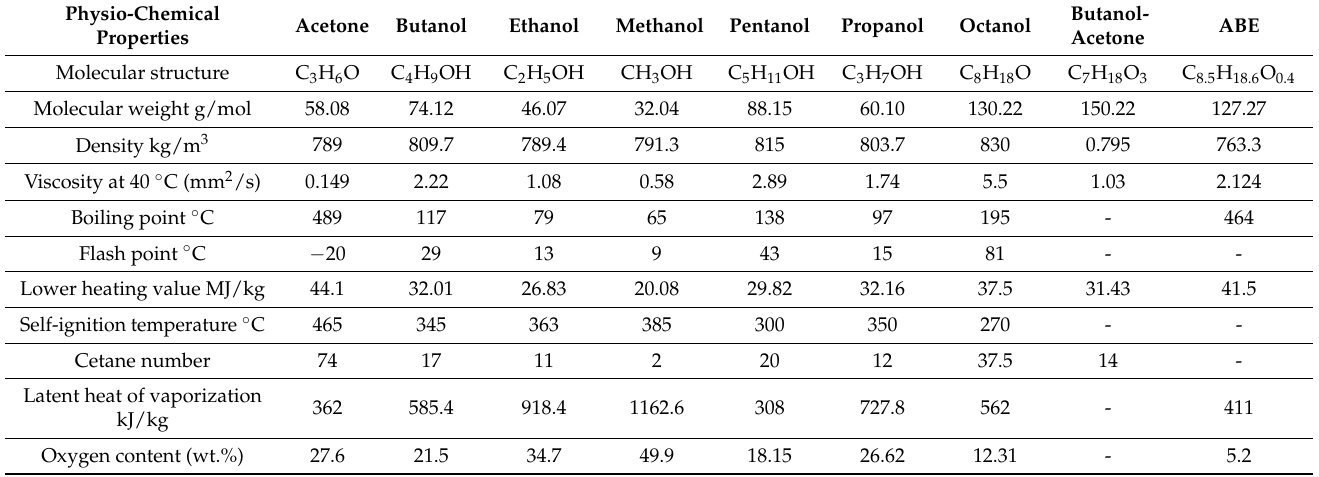
Table 1. Physio-chemical properties of alcohols [34 – 39].